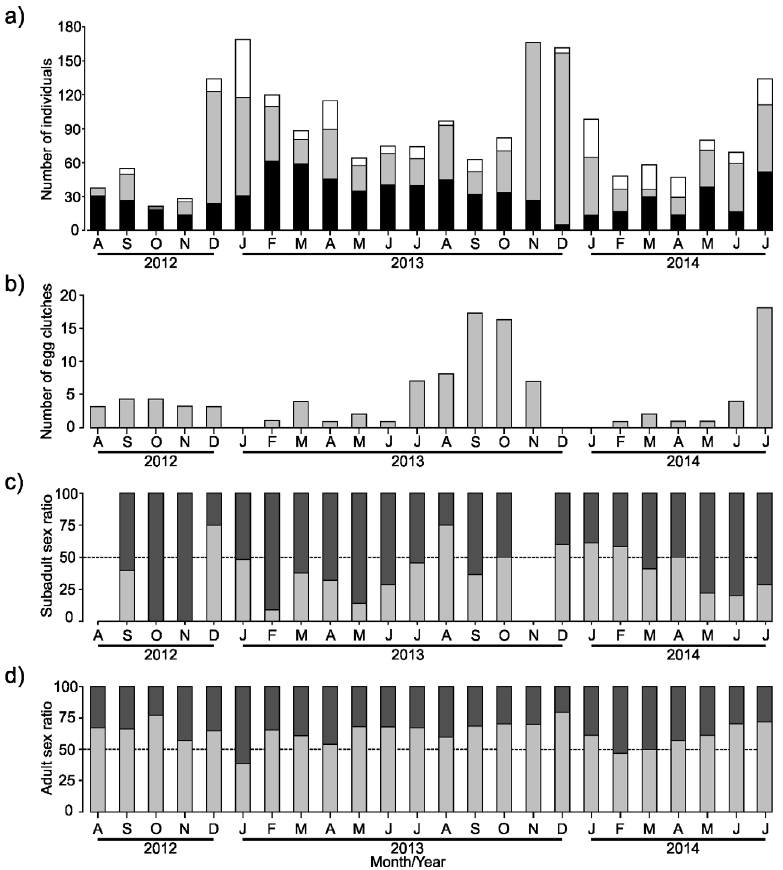
Figure 3. Population